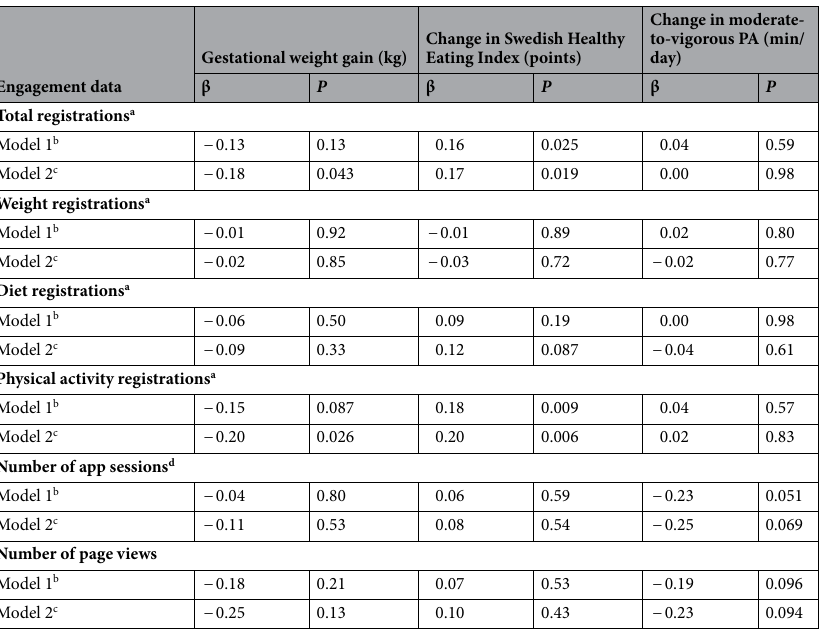
Table 3. Associations of app user engagement with gestational weight gain and change in diet quality and physical activity between gestational week 14 and 37. β Standardized regression coefficient, BMI Body mass index, PA Physical activity. a Refers to the number of registrations from the self-monitoring features for weight-, diet- and physical activity within the HealthyMoms app. b Adjusted for baseline value for the outcome variables (analyses with gestational weight gain was adjusted for baseline BMI). c Adjusted for age, parity, educational attainment, baseline perceived competence for healthy diet and physical activity, baseline BMI as well as baseline value for the outcome variable (for analyses with Swedish Healthy Eating Index and moderate-to- vigorous PA). d An app session represents a single period of user interaction with the